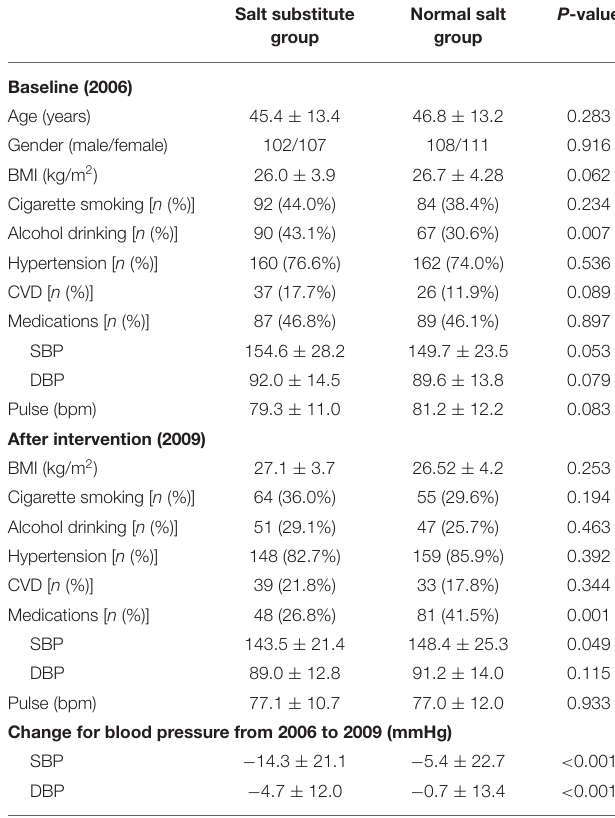
Salt substitute group